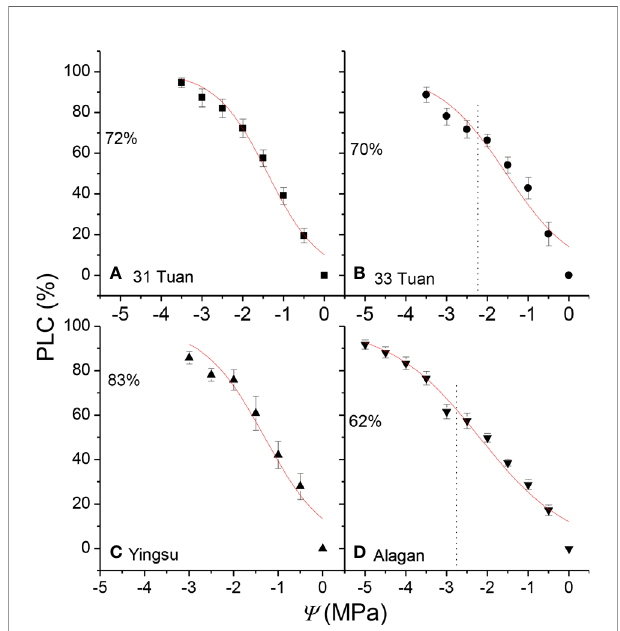
FIGURE 3 | PLC as a function of Y for the four populations of Populus euphratica (means ± 1 se). The curves were fi tted using all data points. The vertical dotted line indicates the position of measured Y min ; the horizontal dotted line indicates the percentage loss of hydraulic conductivity at Y min . The number under the horizontal dotted line is the PLC at noon. See Table 1 for the de fi nition of